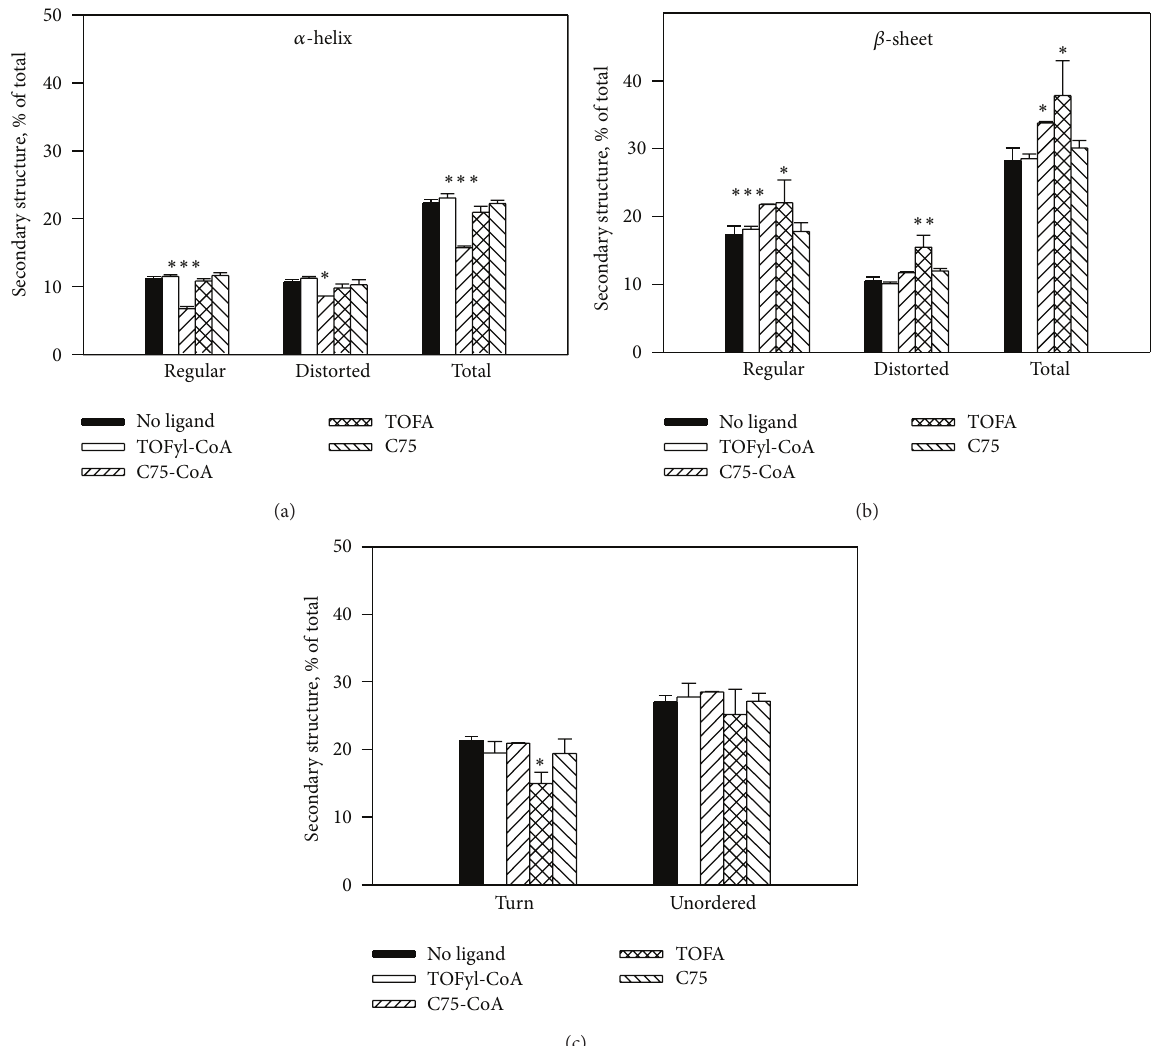
Figure9:SelectivefattyacidsynthesisinhibitorsandtheirCoAthioestersalterL-FABPsecondarystructuredeterminedbycirculardichroism (CD). L-FABP (1 𝜇 M) was incubated in the absence or presence of 10 𝜇 M ligand for 10min at 25 ∘ C. Circular dichroism (CD) spectra were obtained utilizing a JASCO J-815 CD spectrometer (JASCO Analytical Instruments, Easton, MD, USA). Each sample spectrum represented theaverageoftenscans,andeachsamplespectrumwasbaselinecorrected.SecondarystructurewasdeterminedusingtheCONTINalgorithm as supplied by the instrument manufacturer. Statistical significance of secondary structure differences was determined by one-way ANOVA with the Newman-Keuls posttest ( 𝑛 = 3 ). ∗ 𝑃 < 0.05 for L-FABP + ligand versus rat L-FABP (no ligand); ∗∗ 𝑃 < 0.01 for rat L-FABP + ligand versus rat L-FABP (no ligand); ∗∗∗ 𝑃 < 0.001 for rat L-FABP + ligand versus rat L-FABP (no